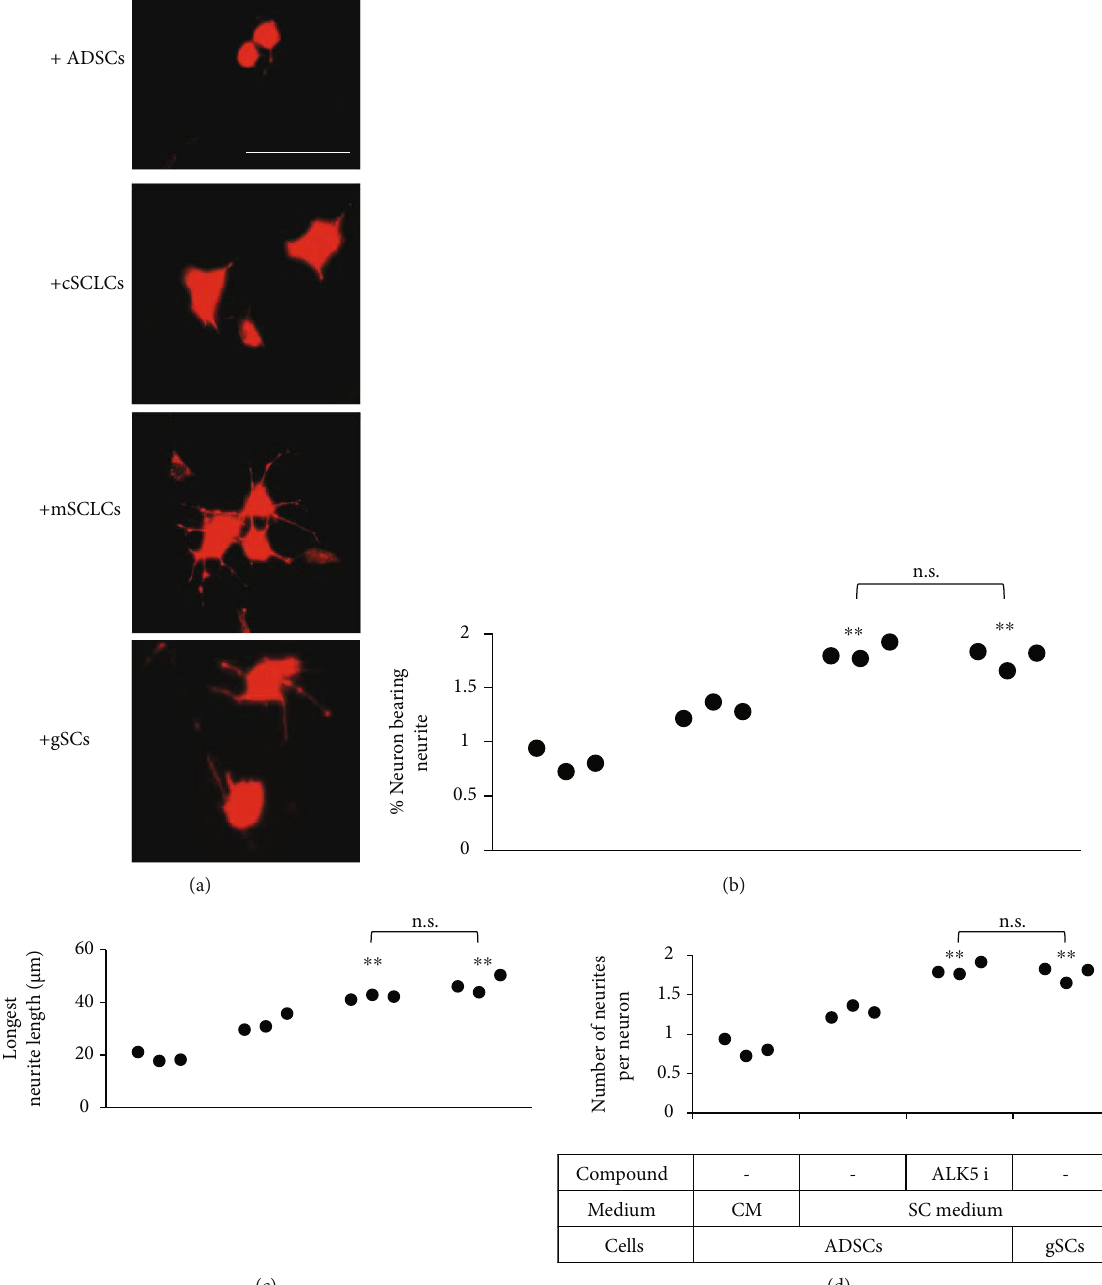
Figure 4: mSCLCs enhanced neurite outgrowth in NG108-15 cells. NG108-15 neuronal cells were cocultured with ADSCs (+ADSCs), cSCLCs (+cSCLCs), mSCLCs (+mSCLCs), or gSCs (+gSCs) for 24h. NG108-15 cells were immunostained with MAP-2 antibody (red fl uorescence) for neurite growth analysis. (a) Representative fl uorescence microscopic images are shown. Scale bar = 100 μ m . (b – d) Percentages of neurons bearing neurites (b), longest neurite lengths (c), and number of neurites per neuron (d) were calculated. Each dot represents a triplicate value. ∗∗ p < 0 : 01 vs. ADSCs cultured in a SC medium alone. n.s.: no signi fi cant di ff erence between the indicated